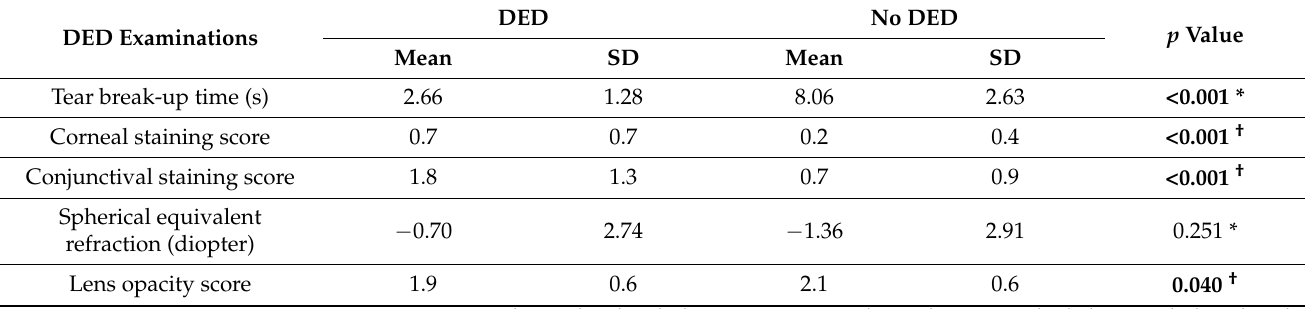
Table 2. Comparison of DED parameters, refraction, and lens opacity score between eyes with and without